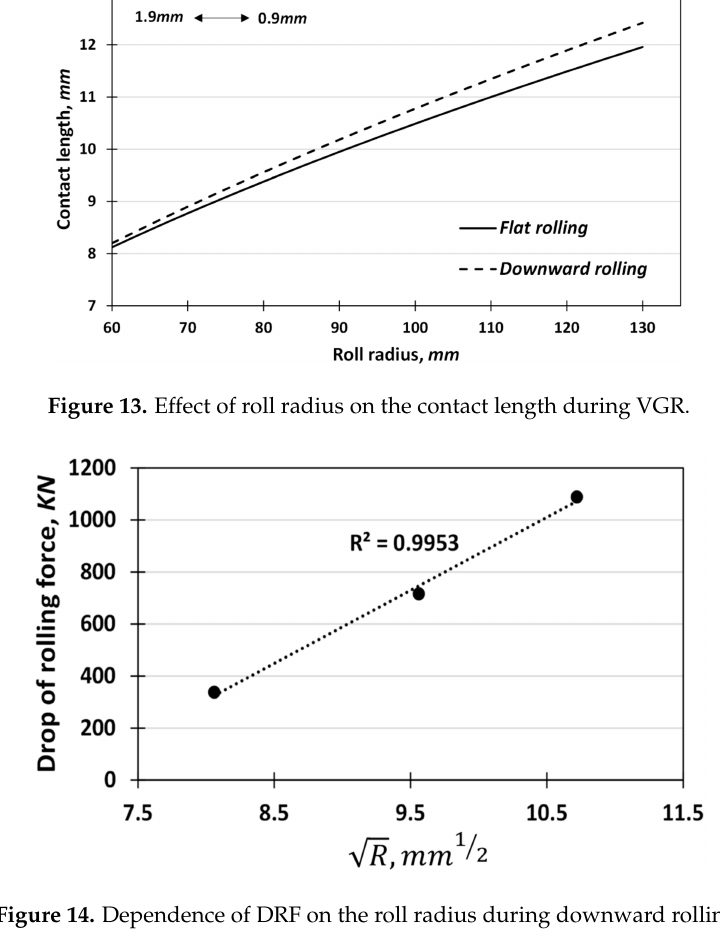
Figure 14. Dependence of DRF on the roll radius during downward rolling.